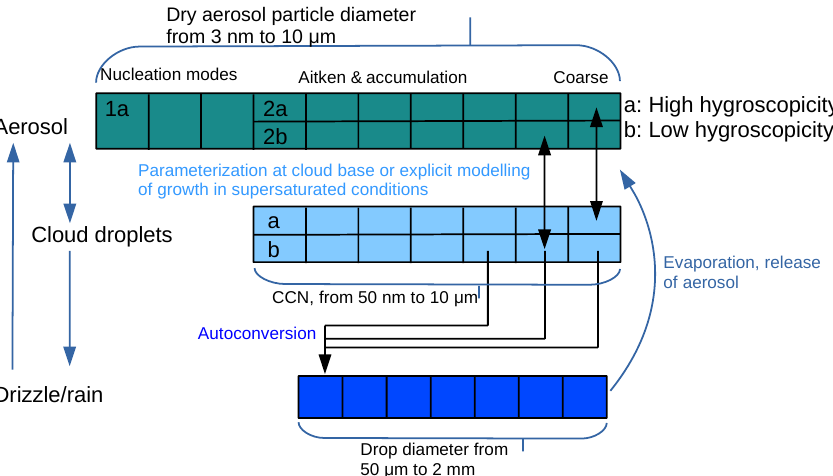
Figure 1. Schematic representation of the bin system and processes included in the extended SALSA module. Aerosol bins (green) cover the size range from 3nm to 10µm, separated into bin regimes 1a, 2a and 2b (see text). Cloud droplet bins (light blue) are parallel to the aerosol bins in terms of the dry CCN diameter above 50nm (i.e. the aerosol bin regime 2a,b). Precipitation bins (dark blue), defined according to the wet diameter of the droplet, cover the size range between 50µm and